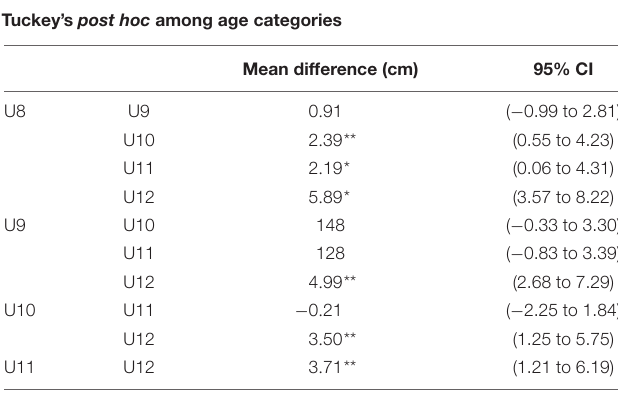
Figure 1 ). The bivariate regression model revealed a negative association between the age categories and hamstrings